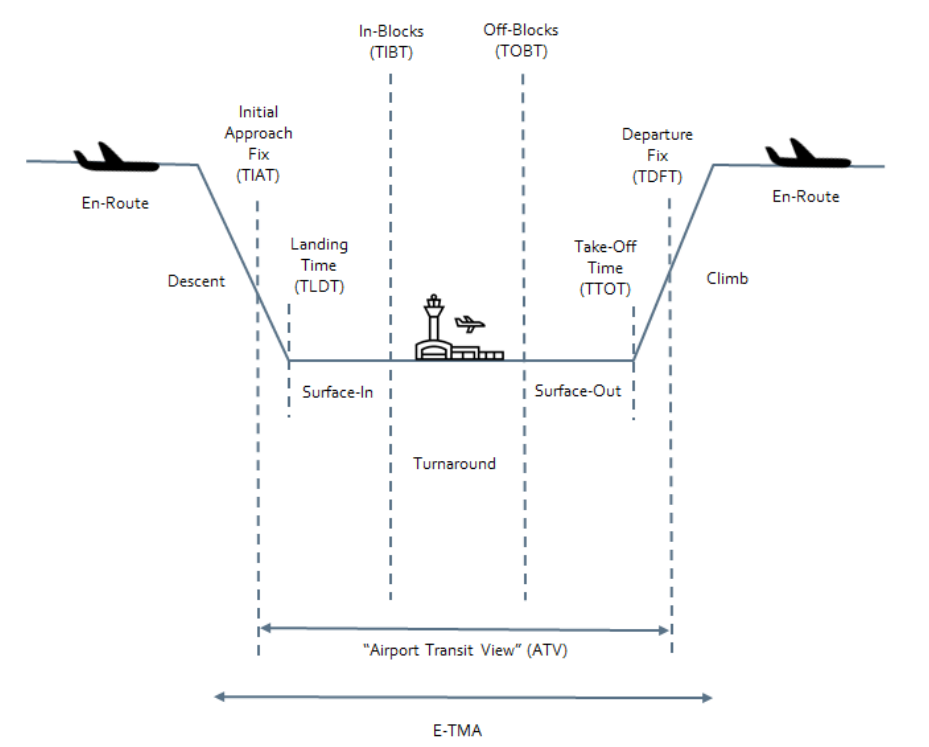
Figure 3. Extension of the ATV concept. Adapted from [9].